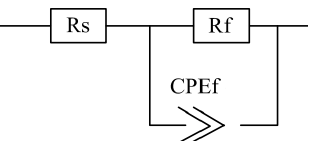
Figure 8. Equivalent electrical circuit used for fitting the EIS data.